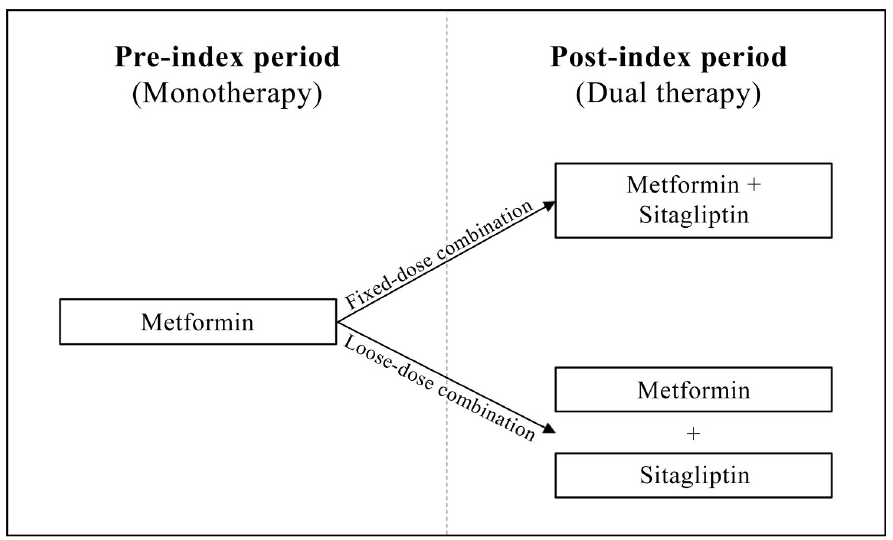
Fig 1. Selection of study cohorts. All patients received metformin monotherapy in a pre-index period of one year and added sitagliptin either as a fixed-dose combination or loose dose combination in a post-index period of three years.